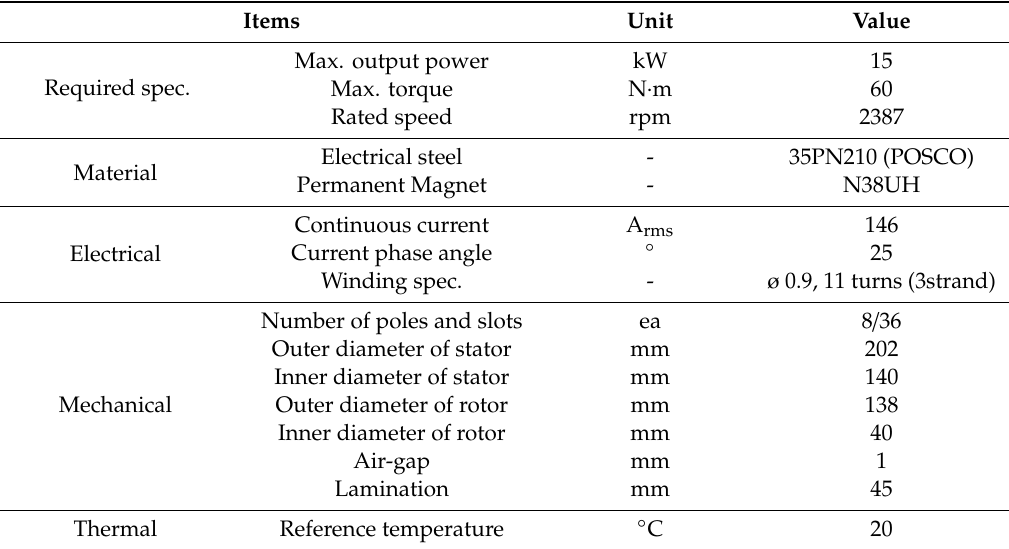
Figure 2. Shape and design variables of the initial permanent magnet synchronous motor model (1/4 model). Table 1. Specifications of analysis model.